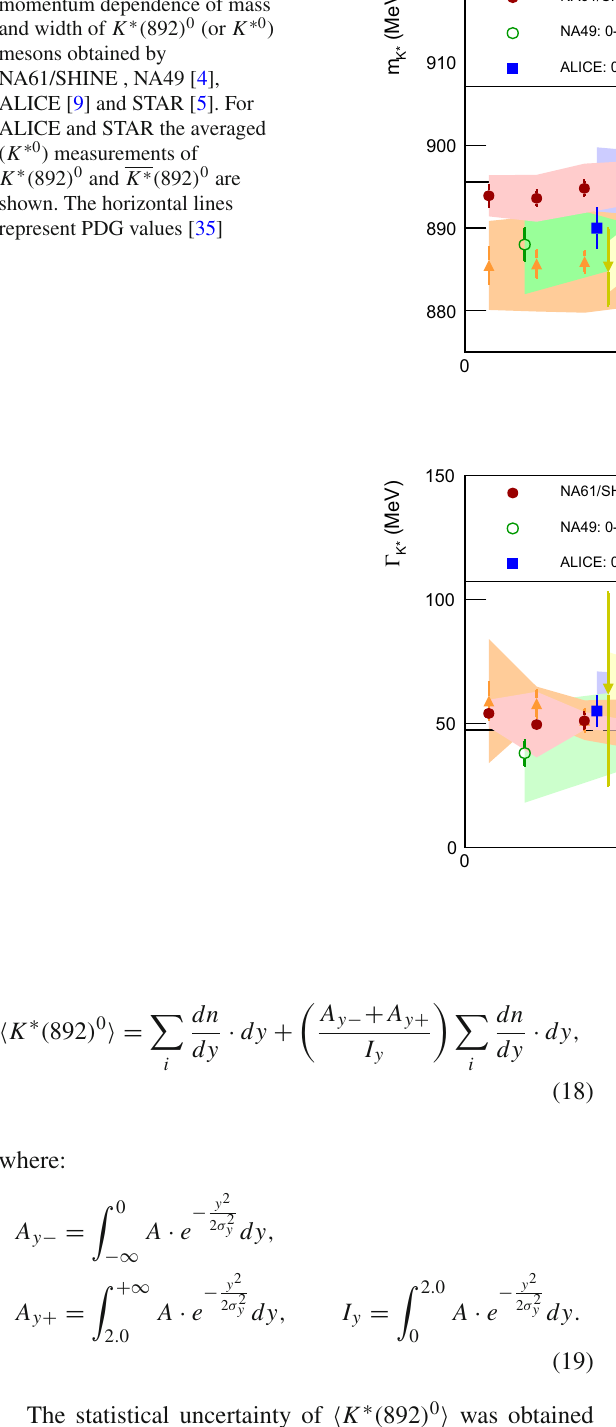
Fig. 13 The transverse momentum dependence of mass and width of K ∗ ( 892 ) 0 (or K ∗ 0 ) mesons obtained by NA61/SHINE , NA49 [4], ALICE [9] and STAR [5]. For ALICE and STAR the averaged ( K ∗ 0 ) measurements of K ∗ ( 892 ) 0 and K ∗ ( 892 ) 0 are shown. The horizontal lines represent PDG values